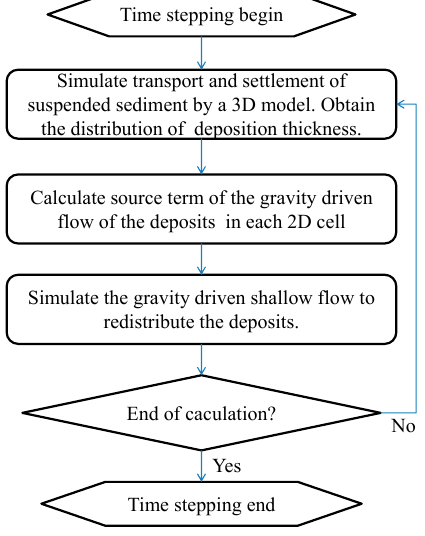
Figure 5. Numerical simulation procedure.